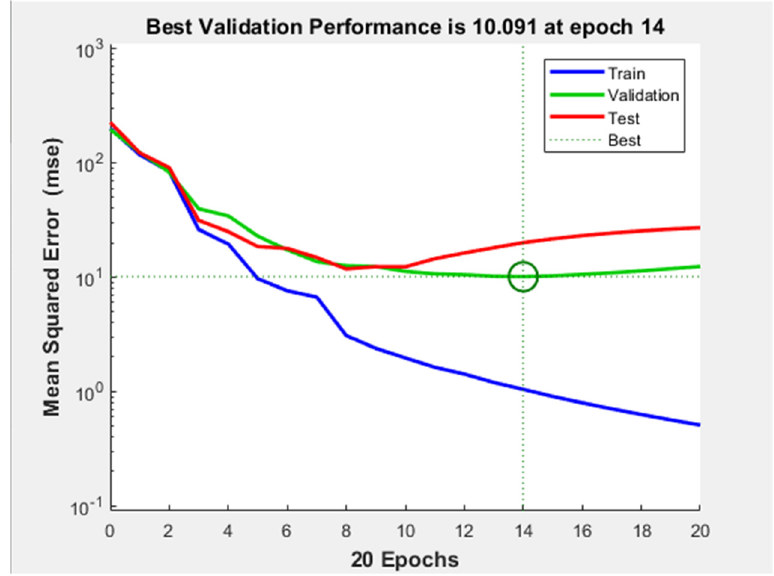
Figure 10. Performance plot of neural network with 10 hidden-layers and 10 neurons on each hidden-layer.